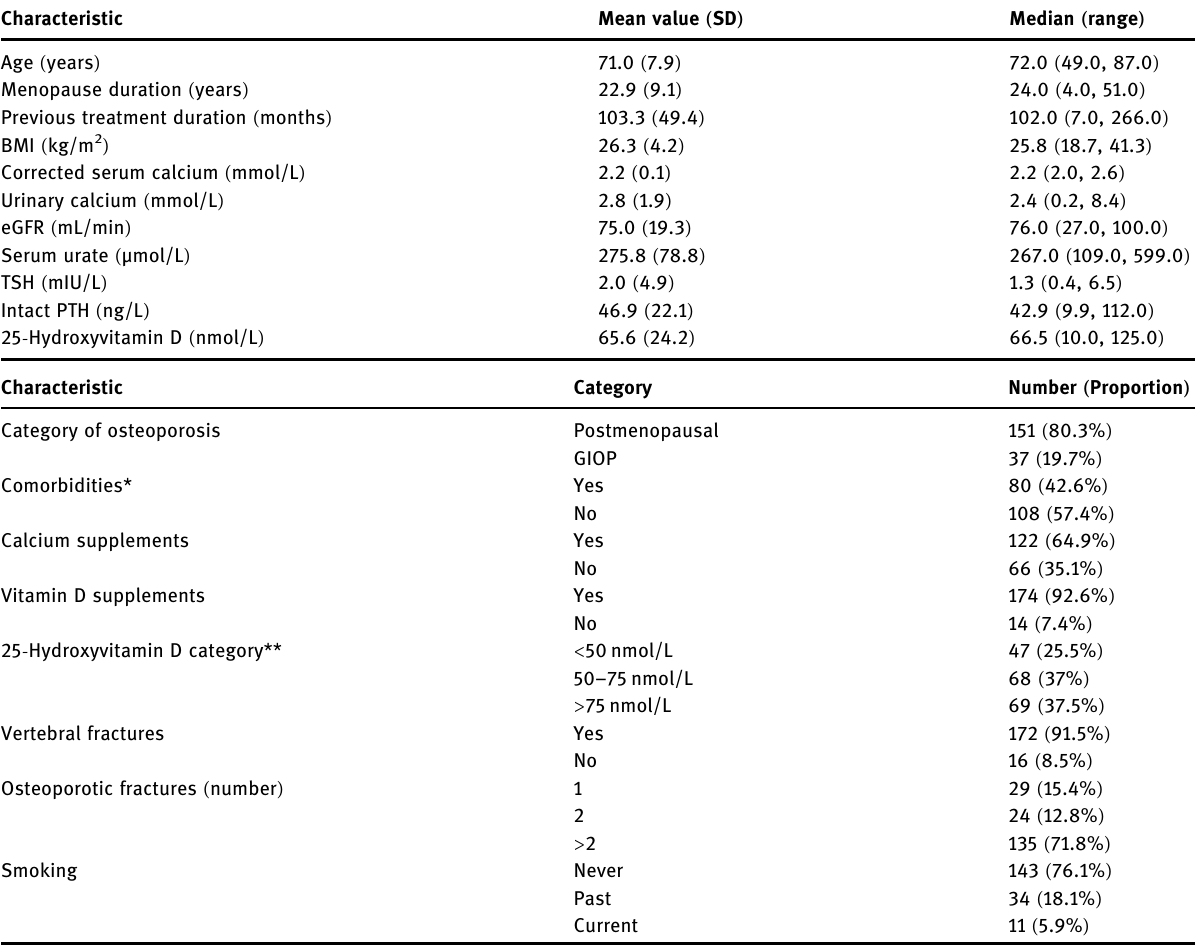
Table 1: Patients ’ clinical and biochemical characteristics